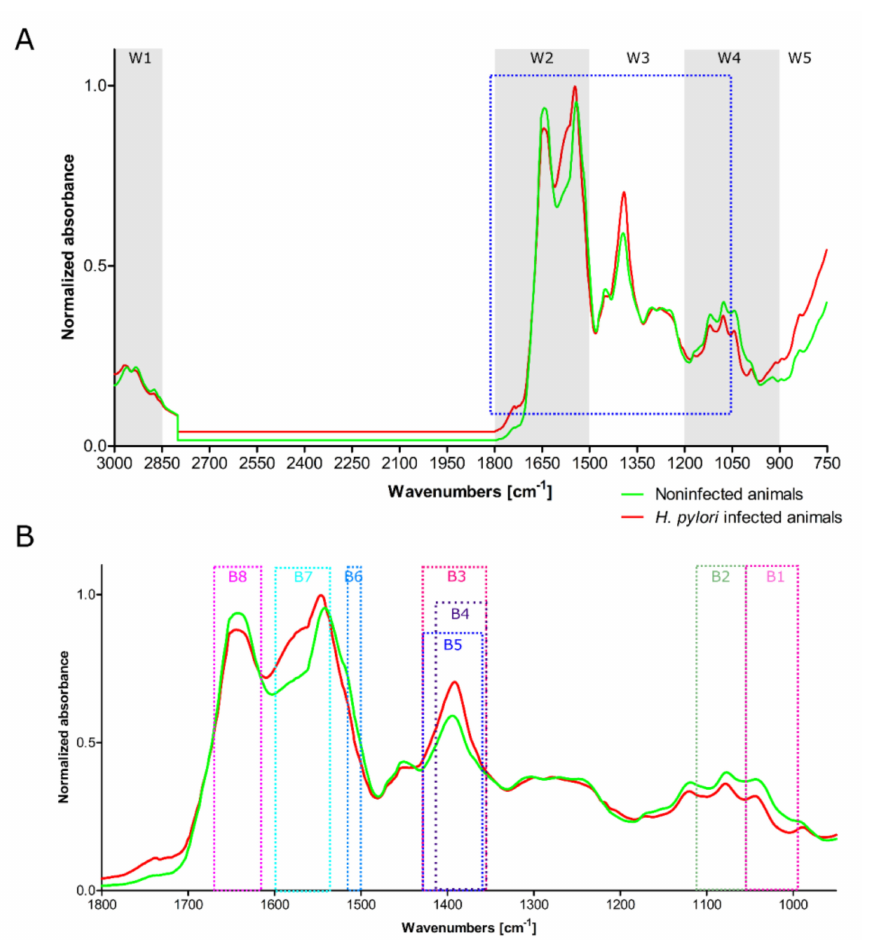
Figure 2. Representative infrared spectra of guinea pig sera. Red— H. pylori positive animals. Green— H. pylori negative animals. ( A ) The full-range IR spectra. Range of the IR spectrum marked in blue that best differentiated between H. pylori infected and noninfected animals. ( B ) Characteristic absorption bands B1–B8 considered in the